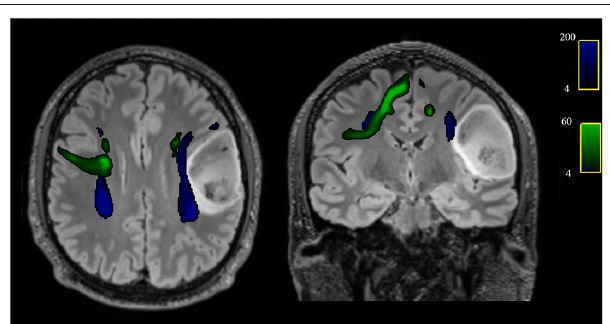
FIGURE 3 | Axial and coronal views of the T2-w FLAIR image with superimposed the reconstruction of the AF (blue) and FAT (green) of one patient with left frontal glioblastoma grade 4, showing the spatial relationship between the tumor and tracts and in particular the displacement of both left AF and FAT.